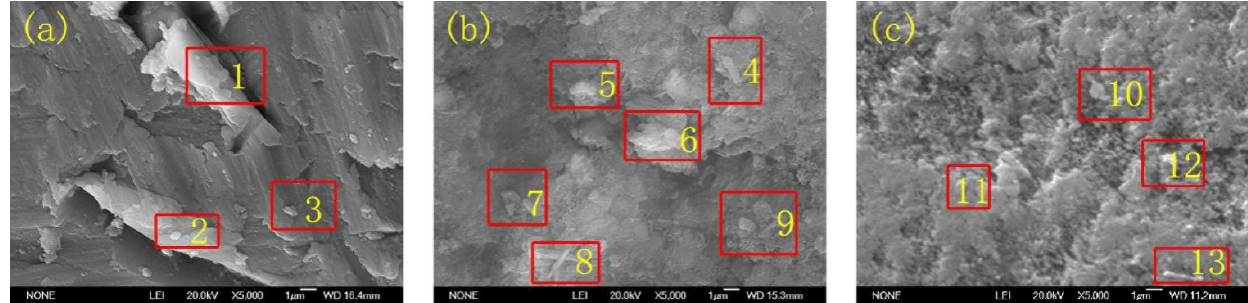
Figure 3. SEM image of ( a ) AA 5052, etching morphology of ( b ) bare surface and ( c ) after being treated by hydro-thermal technology at 400 °C for 2 h (the coating was stripped). Notes: the etchings were performed in 20 wt.% HNO 3 solution. Before the etching, the treated coatings were stripped from the substrate. Table 2. The elements composition at different positions.